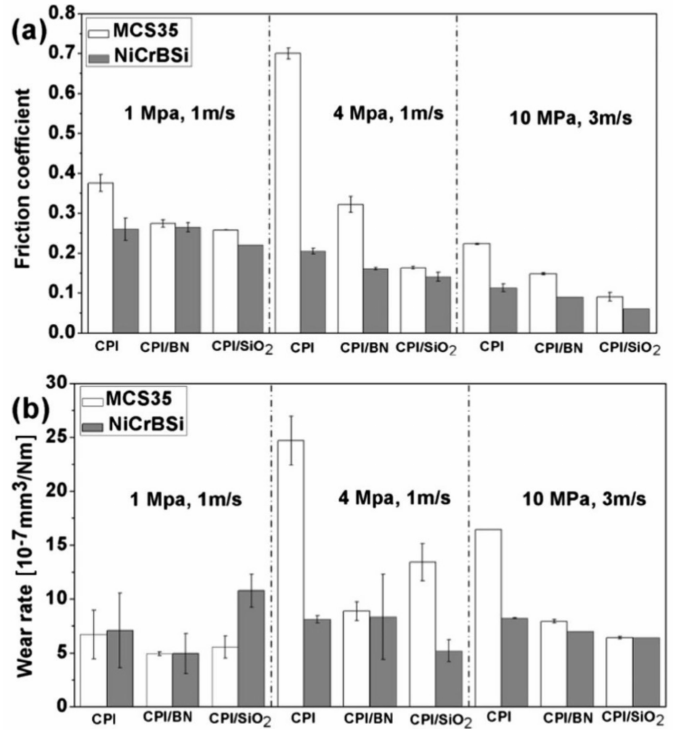
Figure 14. ( a ) Average friction coefficient and ( b ) wear rate of CPI and CPI hybrid nanocomposites when sliding against MCS35 and NiCrBSi at a PV factor of 1, 4 and 30 MPa · m/s (Reproduced with permission from H. Qi, G. Li, G. Liu, C. Zhang, G. Zhang, T. Wang, Q. Wang, Journal of Colloid and Interface Science; published by Elsevier, 2017)